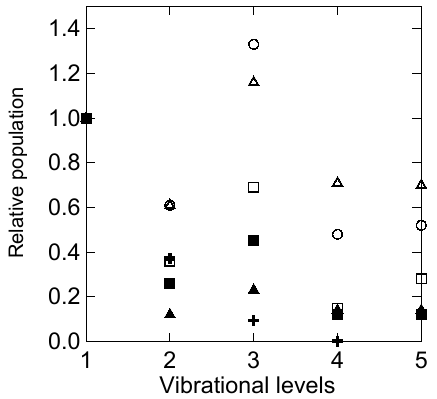
Fig. 4. Relative vibrational populations [O 2 (b 1 6 + g , v =1– Figure 4. Relative vibrational populations [O 2 (b 1 Σ g+ ,v=1-5)]/ [O 2 (b 1 Σ g+ ,v=1)]: 5)]/[O 2 (b 1 6 + g , v =1)]: results of our calculation for h =80km – results of our calculation for the altitude 80 km – crosses; experimental data of Vallance Jones and Gattinger (1974) – circles, Gattinger and Vallance crosses; experimental data of Vallance Jones and Gattinger (1974) Jones (1976) for normal and high aurora – open and solid triangles, respectively, Henriksen and – circles, Gattinger and Vallance Jones (1976) for normal and high Sivjee (1990) for normal and high aurora – open and solid squares, respectively. aurora – open and solid triangles, respectively, Henriksen and Siv- jee (1990) for normal and high aurora – open and solid squares,